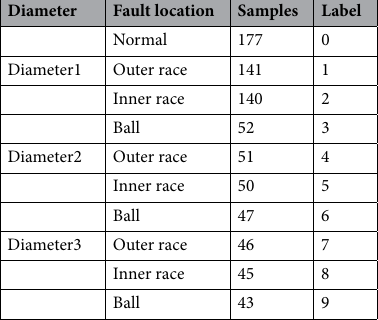
Table 1. Data Castle bearings dataset.